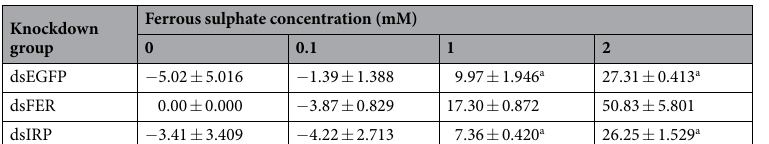
Table 3. Ferrous iron concentration (pmol/ μ g protein) of knockdown cells exposed to different concentrations of ferrous sulphate at 48 h. Data are presented as mean ± S.D. The results for the normality and homogeneity are presented in Table S7. A one-way ANOVA with Bonferonni multiple comparison test was performed (Tables S8 and S9). Statistical significance was set as * P < 0.05. Columns with the same superscript are not significantly different at P < 0.05. The data presented are results of three separate experiments with two technical replicates for each